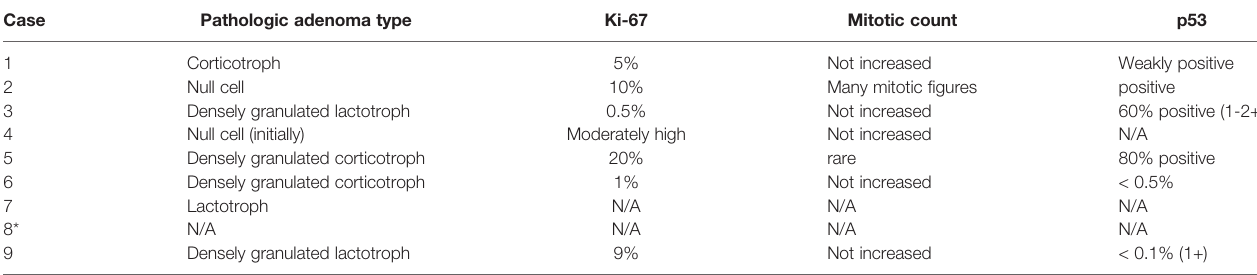
TABLE 2 | Pathologic